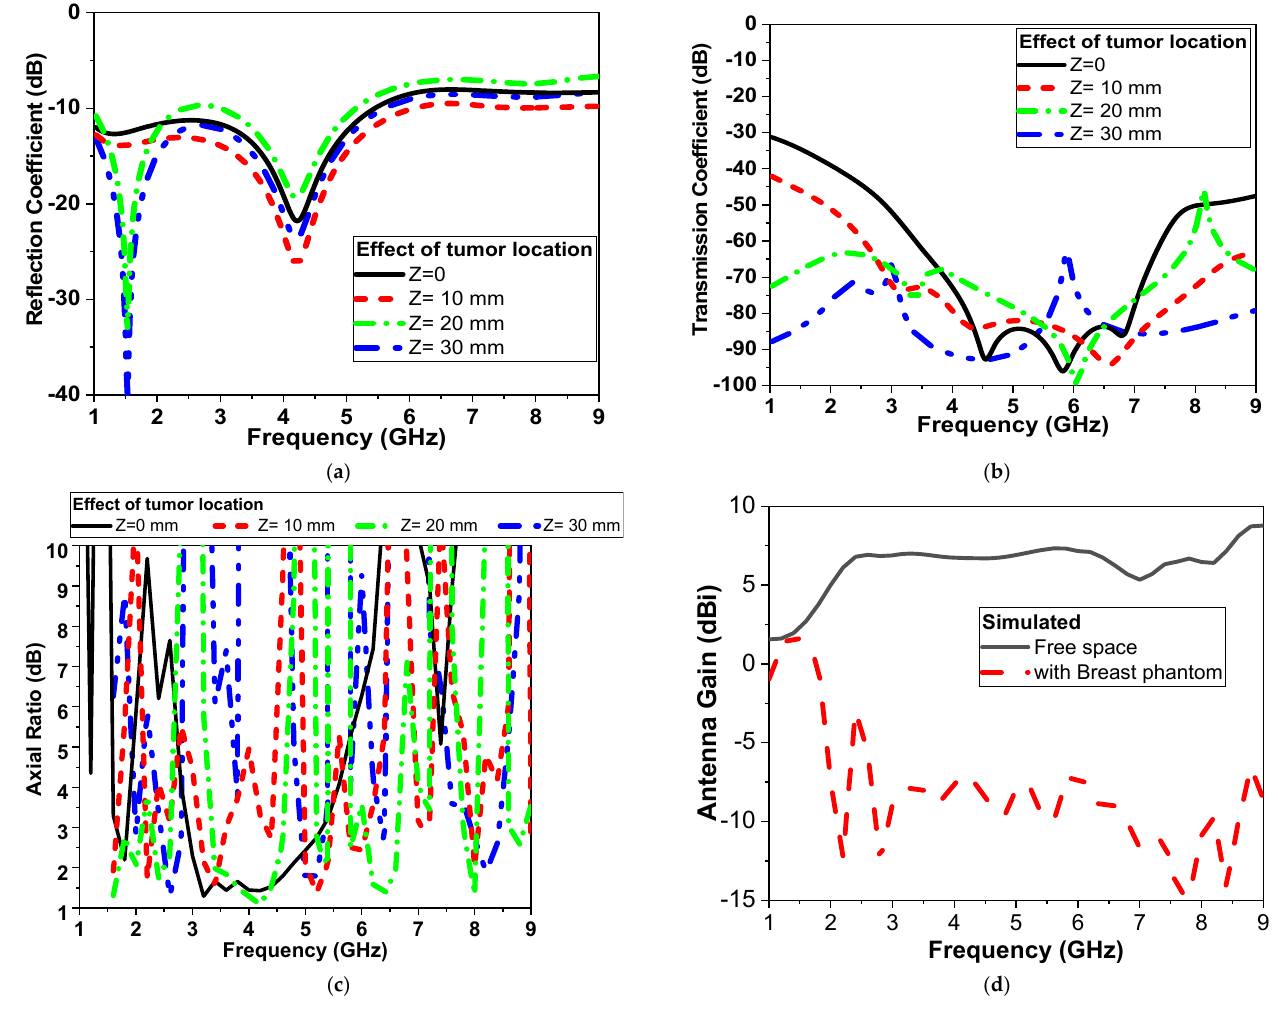
Figure 15. Simulated of proposed CPMS parameters with tumor location (second scenario shown in Figure 10b) ( a ) |S 11 | ( b ) |S 21 | in dB, ( c ) Axial ratio and ( d ) antenna Gain.